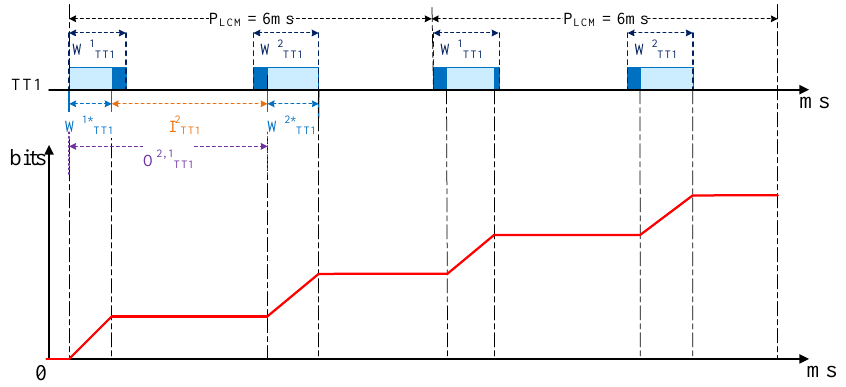
Figure 7. Worst-case service curve of TT1.